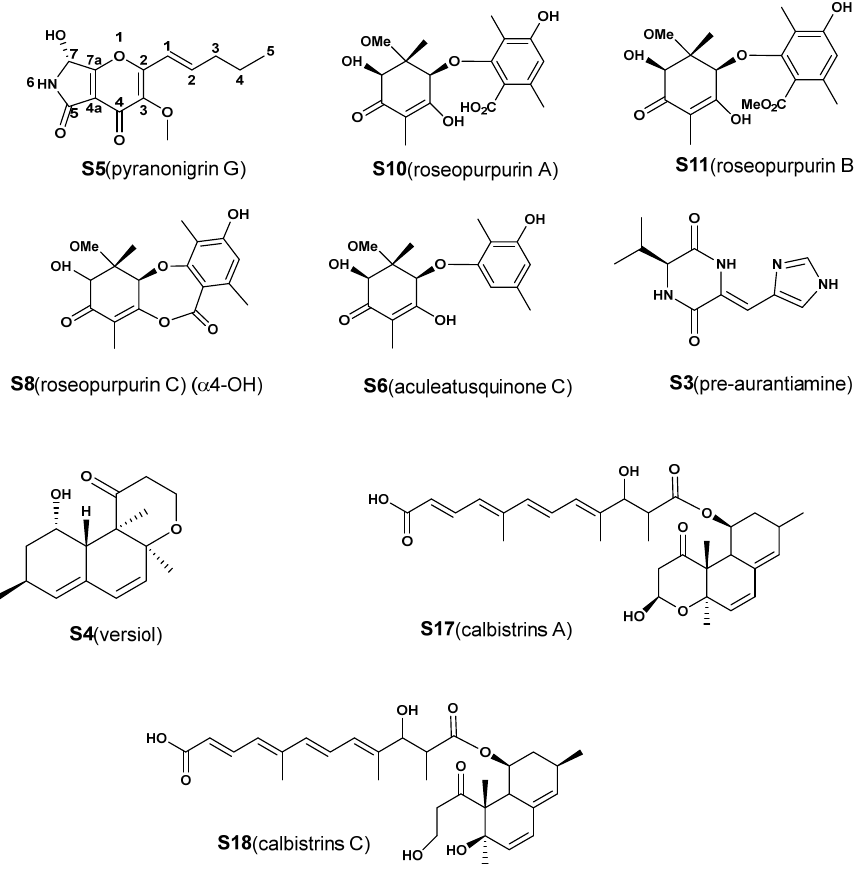
Figure 6. Structures of metabolites that have contributed significantly to the classification of groups and that have been isolated for structure identification.